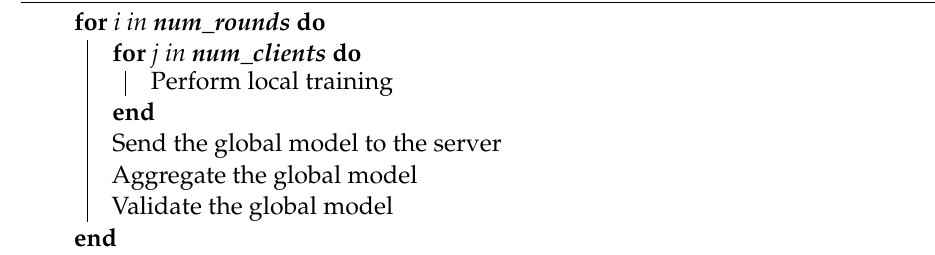
Algorithm 2: Training steps of our FL implementation.